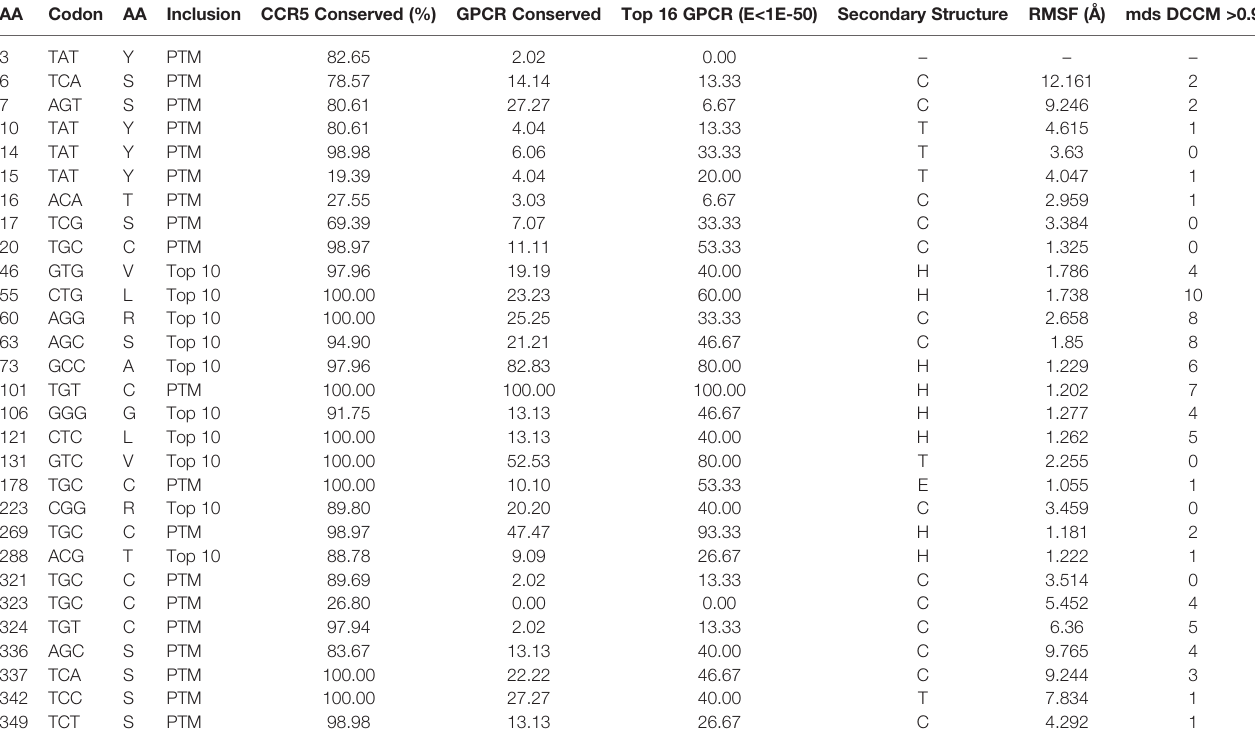
TABLE 1 | Top functional amino acids of CCR5 from amino acid knowledgebase.